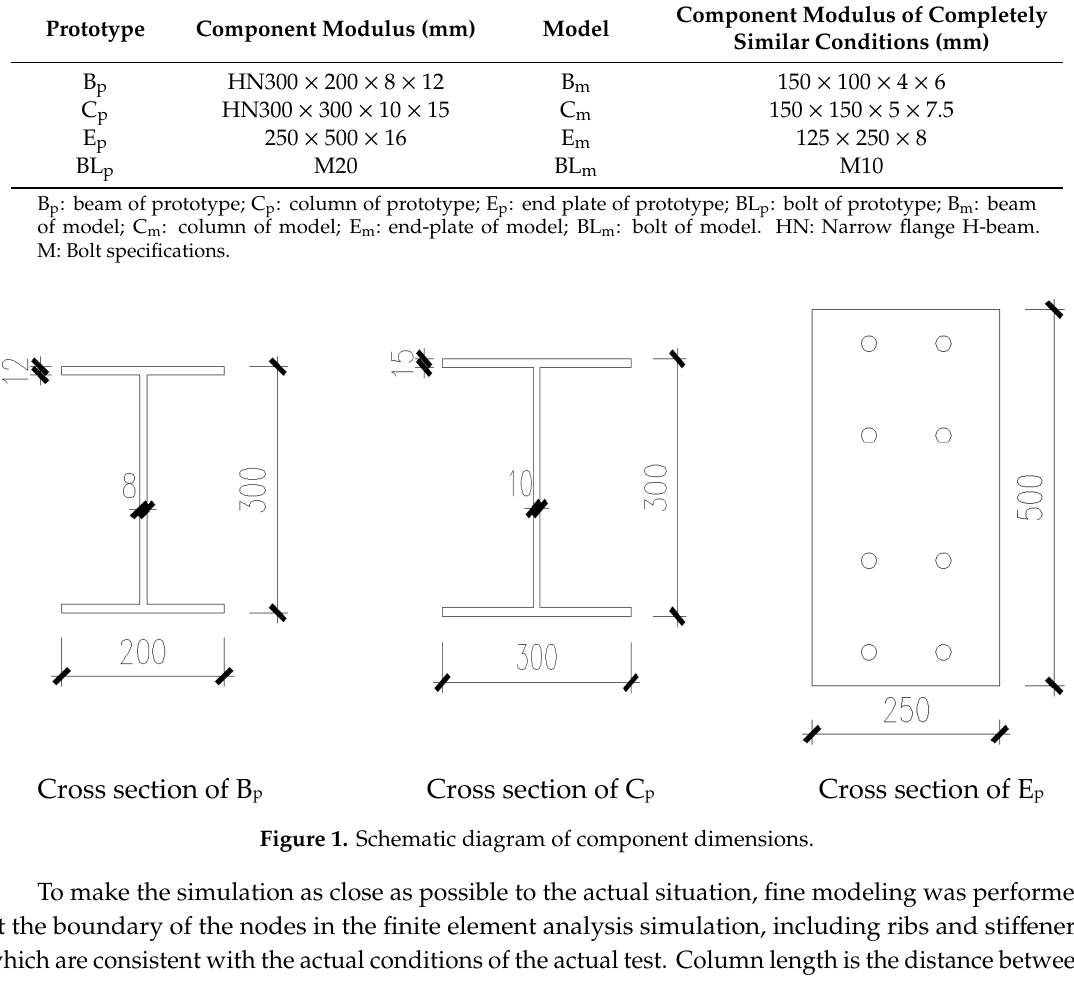
Table 4. Component modulus of completely similar conditions.